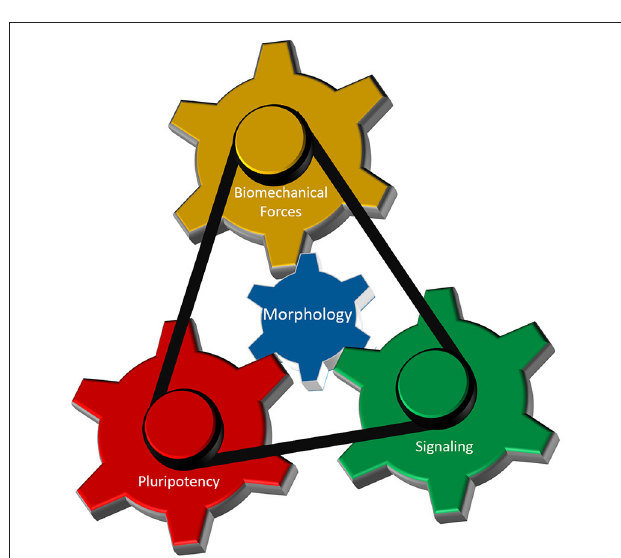
FIGURE 4 | Cellular morphology as the fundamental parameter that coordinates different regulatory components of 3-D morphogenesis. Biomechanical forces, cellular potency and molecular signaling are the main components that dictate early morphogenesis of an embryo. Cellular morphology, defined by its epithelial and/or mesenchymal status, interacts with each of those three components to induce local variations in cellular responses necessary for the formation of highly reproducible structure in an early